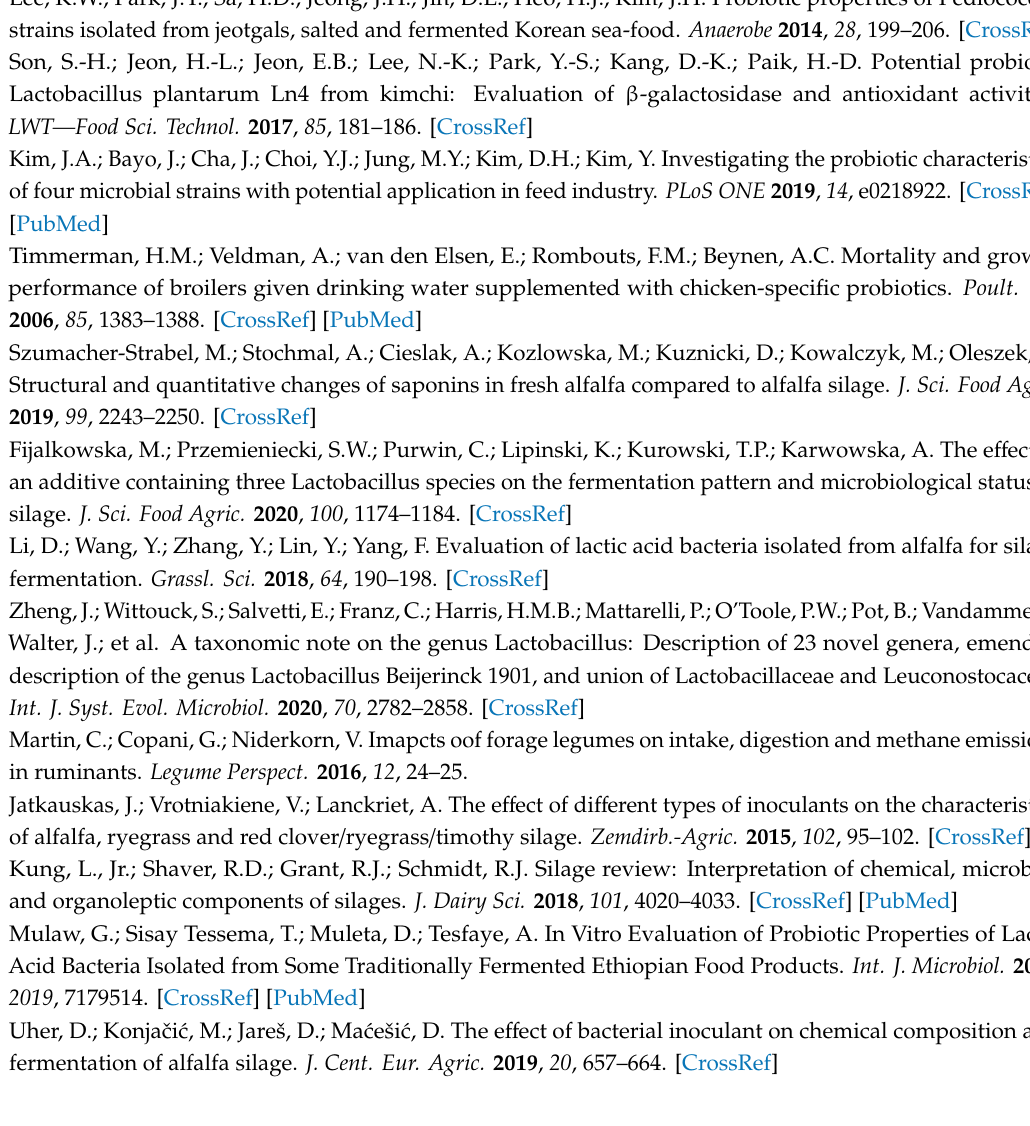
Figure S1: Assessment of cell-surface hydrophobicity of L. plantarum RJ1 and P. pentosaceus S22; Figure S2: The auto and co-aggregation abilities of RJ1 and S22 (SA- Staphylococcus aureus ; EC- E.coli pathogens); Table S1: Carbohydrate-fermentation of RJ1 and S22 using API 50 CHL test kit; Table S2: Qualitative analysis of enzyme production of RJ1 and S22 using API-ZYM test kit; Table S3: Antibiotic resistance profile of L. plantarum RJ1 and P. pentosaceus S22 analyzed by the disc-di ff usion method (S-susceptible; R-resistant;